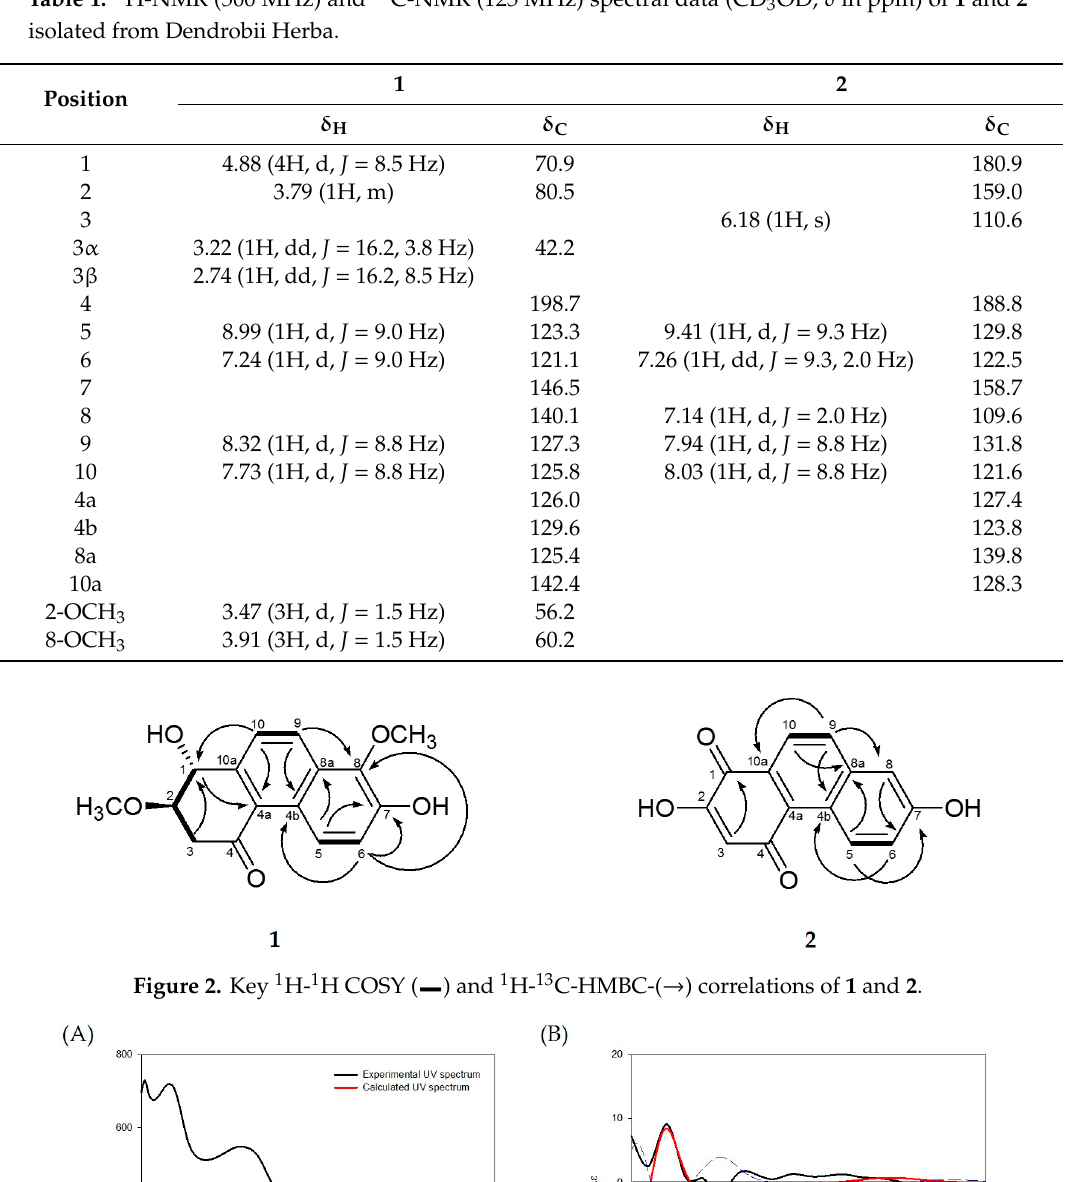
Table 1. 1 H-NMR (500 MHz) and 13 C-NMR (125 MHz) spectral data (CD 3 OD, δ in ppm) of 1 and 2 isolated from Dendrobii Herba.